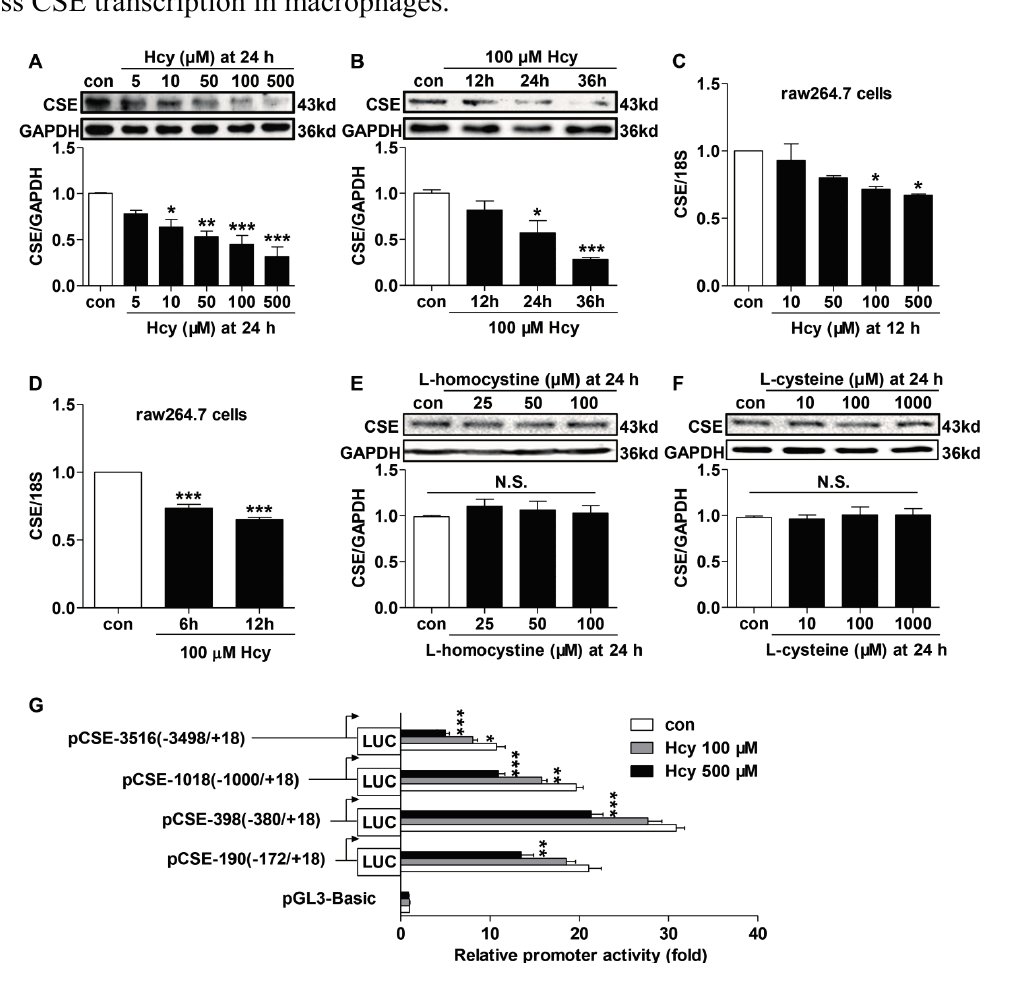
Figure 3. Effects of Hcy on CSE expression and promoter activity in